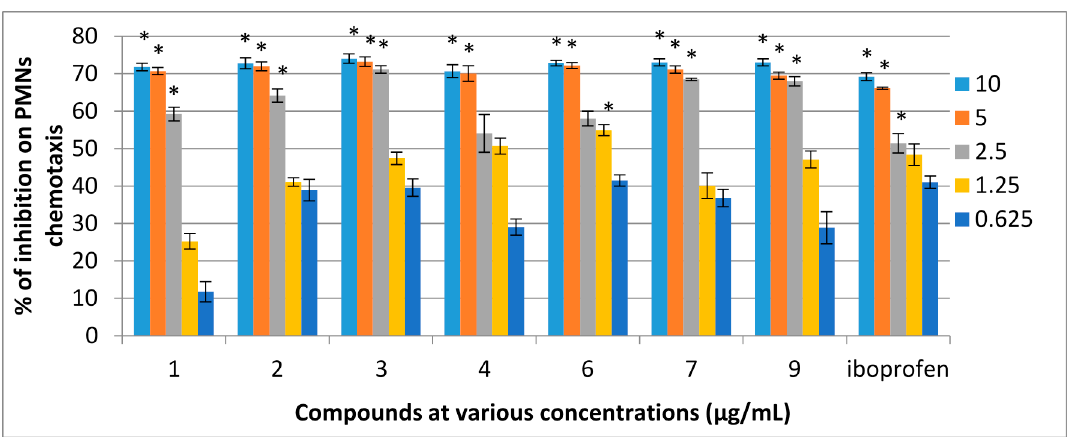
Figure 3. Dose dependent percentage of inhibition of compounds of F. aurantiaca on PMNs chemotaxis. Data are mean ± SEM ( n = 3). * p < 0.05 is significant difference compared with the respective control determined by one-way ANOVA followed by Tukey’s test. Table 2. IC 50 values of compounds isolated from F. aurantiaca.